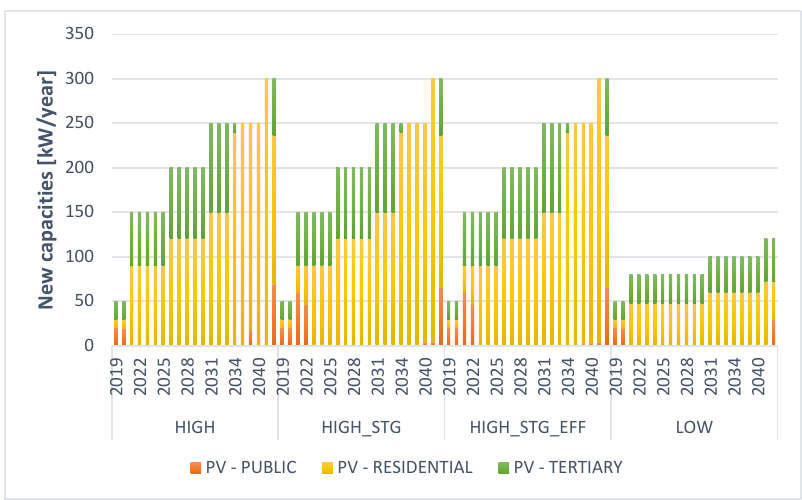
Figure 13. Effect of storage on public sector electricity imports.